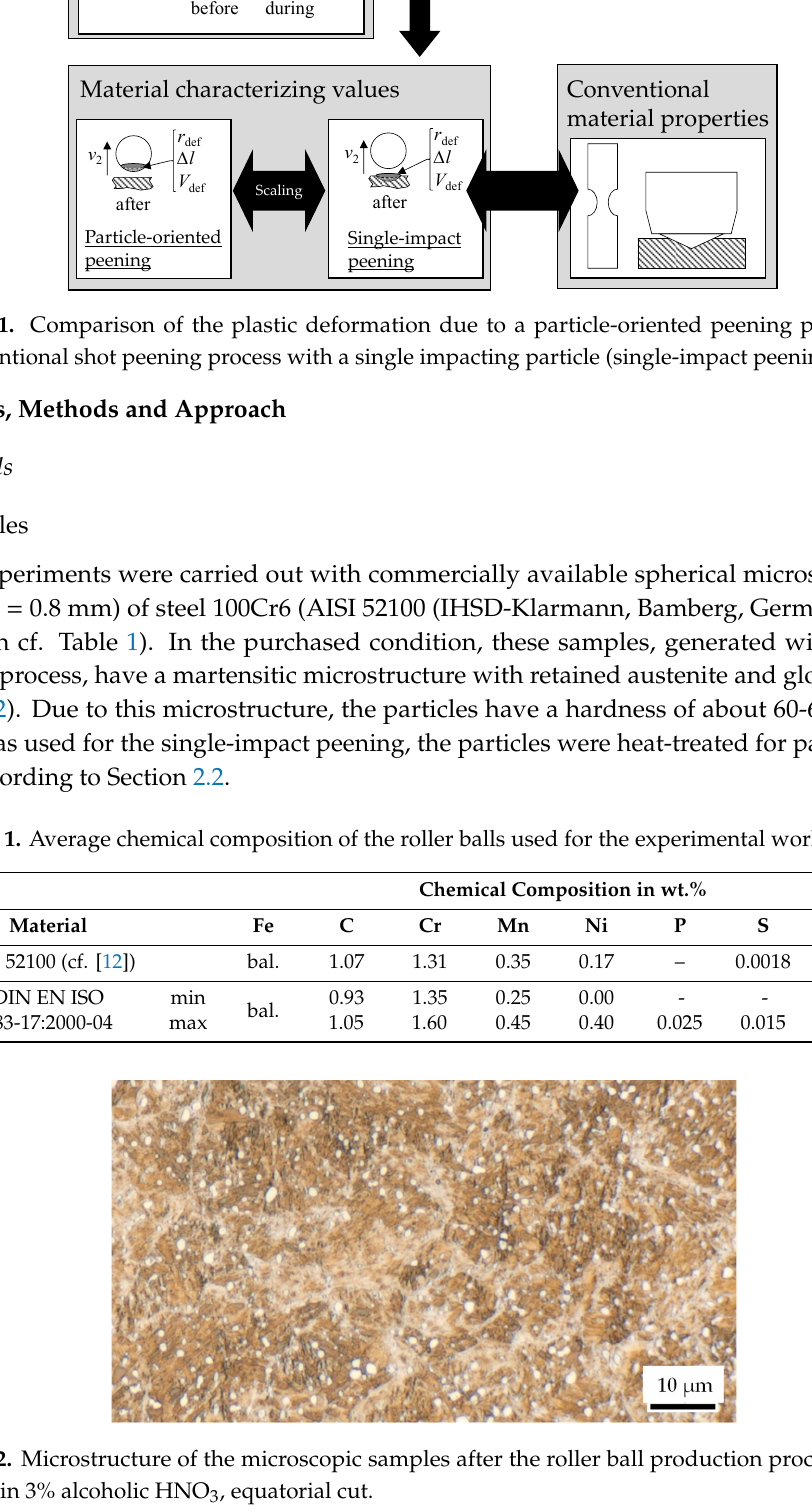
0.26 Figure 3. Initial microstructure (before heat treatment) of the macroscopic samples (single-impact peening); etched 25–40 s in 3% alcoholic HNO 3.